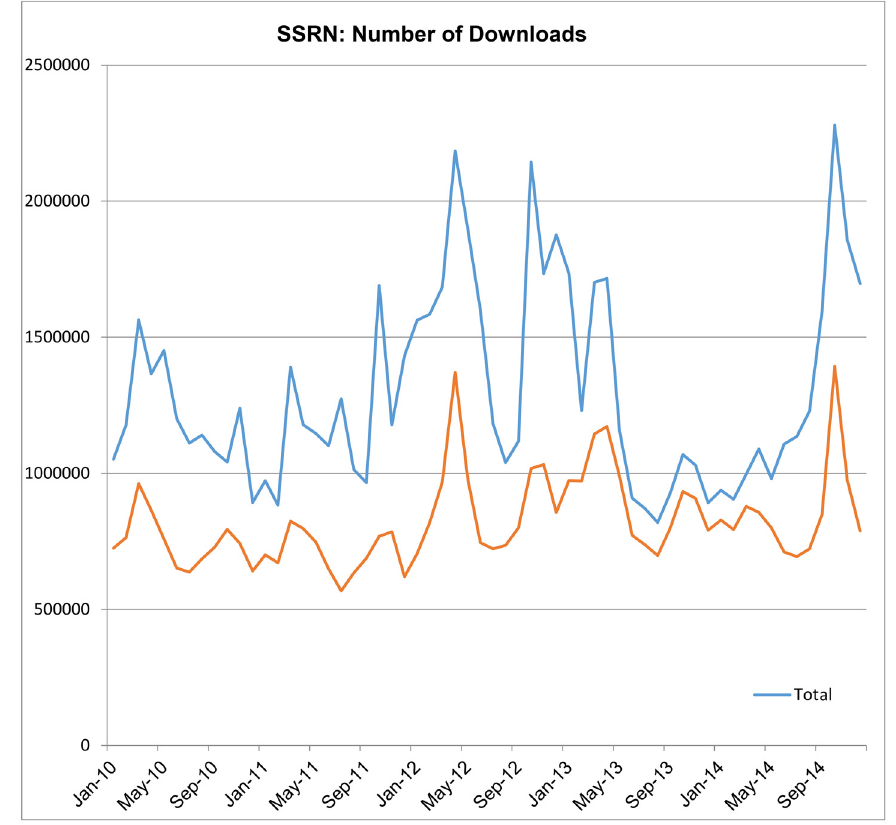
Fig 2. SSRN fraudulent activity